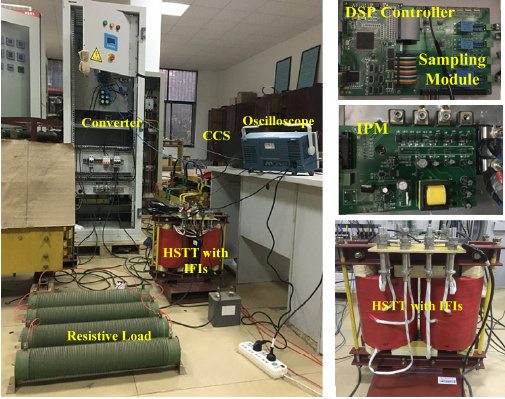
Figure 15. Photography of the experimental system.